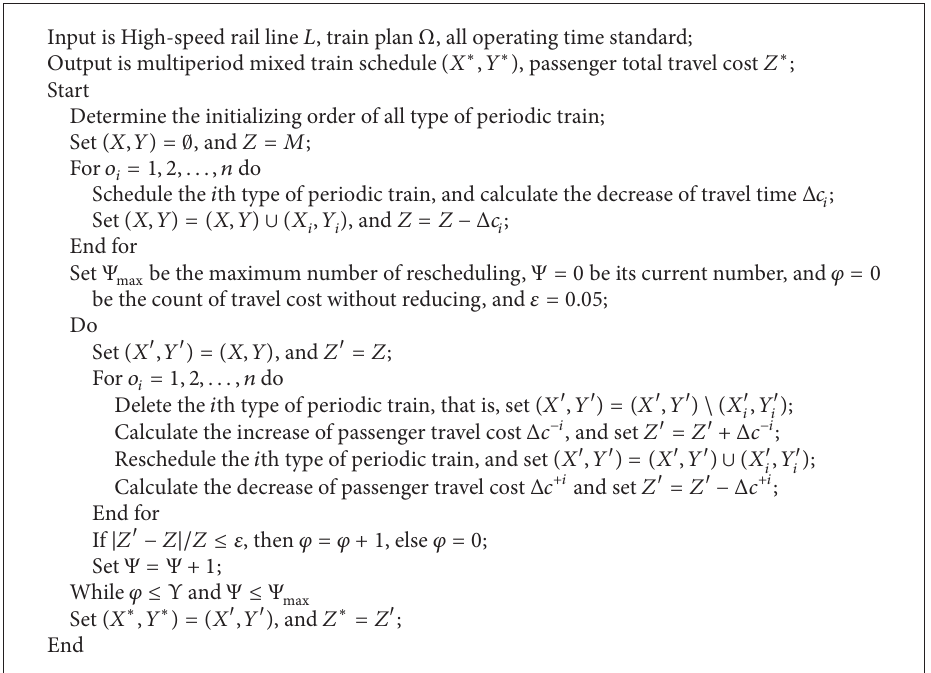
Table 2: All types of trains and their numbers.